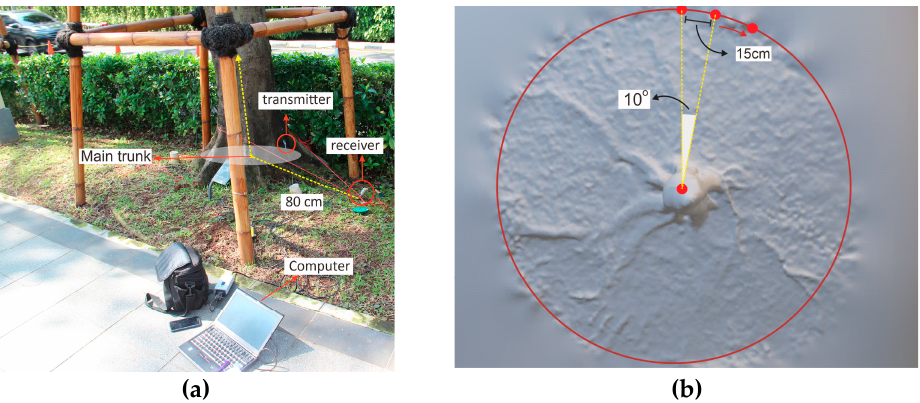
Figure 1. An experimental setup in the field for root detector testing: (a) Fakopp Root Detector set in the tree, and (b) 15 cm steps in a circle at a distance of 80 cm from the midpoint of the main trunk.